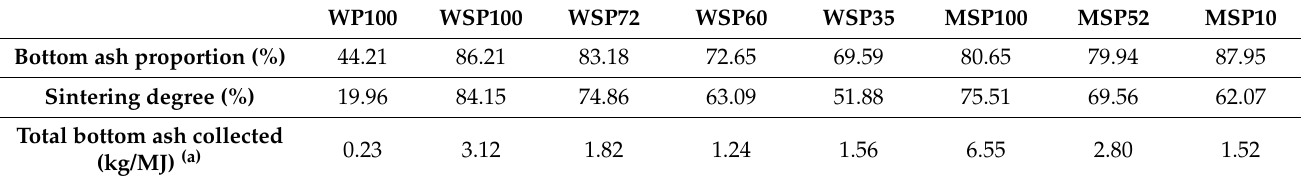
Table 9. Bottom ash proportion and sintering degree obtained with each fuel (mean of all tests).